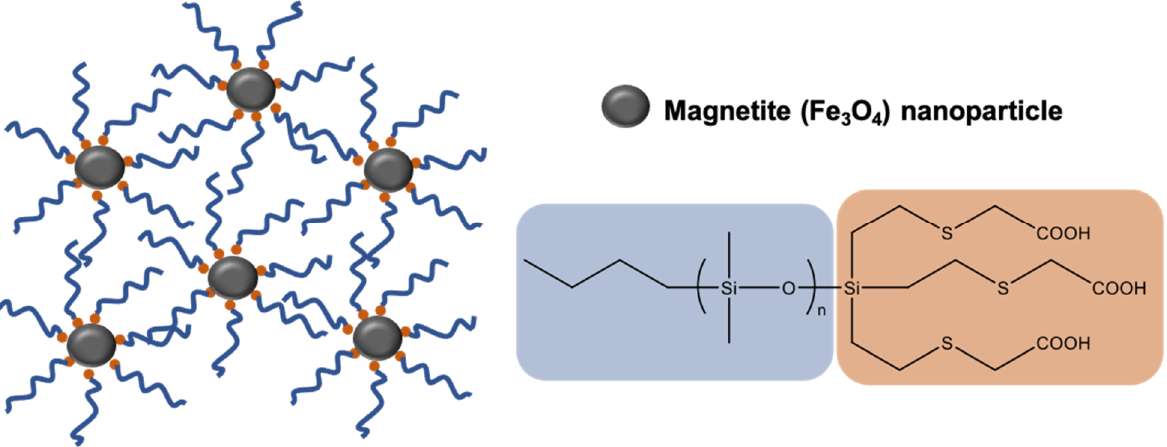
Figure 8. PDMS macromer-modified SPIONs (Author’s work).